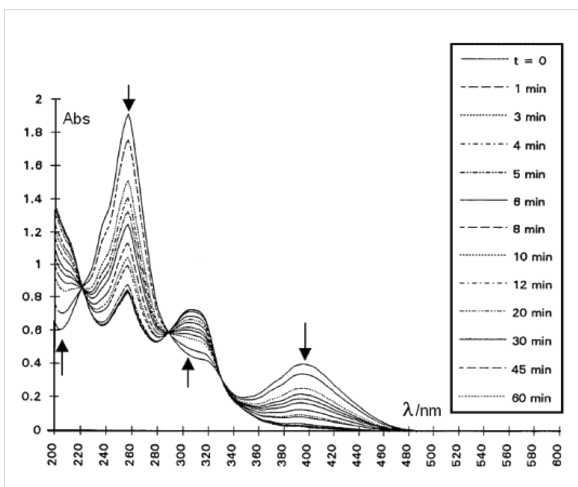
Figure 7: Irradiation of 2 (2.6 × 10 −5 M) in CH 3 CN at 400 nm at 20 °C. The spectra were recorded at various time intervals within 60 min. The arrows point to the maxima.